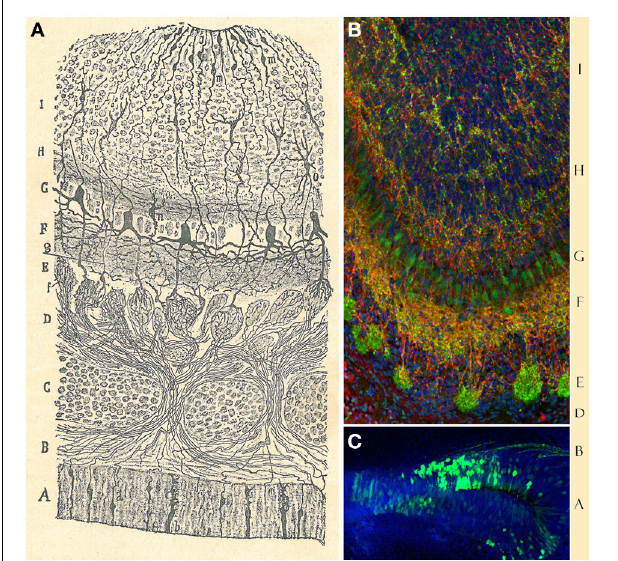
FIGURE 2 | Olfactory bulb and epithelium. (A) Original Cajal drawing showing the “antero-posterior view of the olfactory bulb and nasal mucosa of the newly-born mouse.” (A) olfactory epithelium; (a) olfactory sensory neuron; (b) sustentacular cell. (B) Dermis. (C) Ethmoid bone. (D) Fibrillar layer. (E) Glomerular layer. (F) Inferior molecular layer. (G) Mitral cells layer. (H) Superior molecular region. (I) Granular zone. (c) Cartilage. (e) Olfactory nerve. (f) Arborization of the olfactory fibers within the glomeruli. (g) Central cyllinder-axis of an inferior tufted cell. (h) Mitral cell. (i) Grains. (j) Epithelial cells. (n) Lower grain. (o) Large stellated cell (Ramón y Cajal, 1890b). (B) Immunohistochemical staining for Dab1 protein (reelin signaling mediator, green) and Map2a,b protein (microtubule associated protein, red) on mouse olfactory bulb sections at P3. Nuclei counterstained with Hoechst (blue) (Martín-López et al., 2011). (C) Olfactory sensory neurons (green) at E17, labeled after in utero electroporation of an EGP-expressing plasmid into the olfactory placode at E11. Nuclei counterstained with Hoechst (blue). Sagittal mouse brain